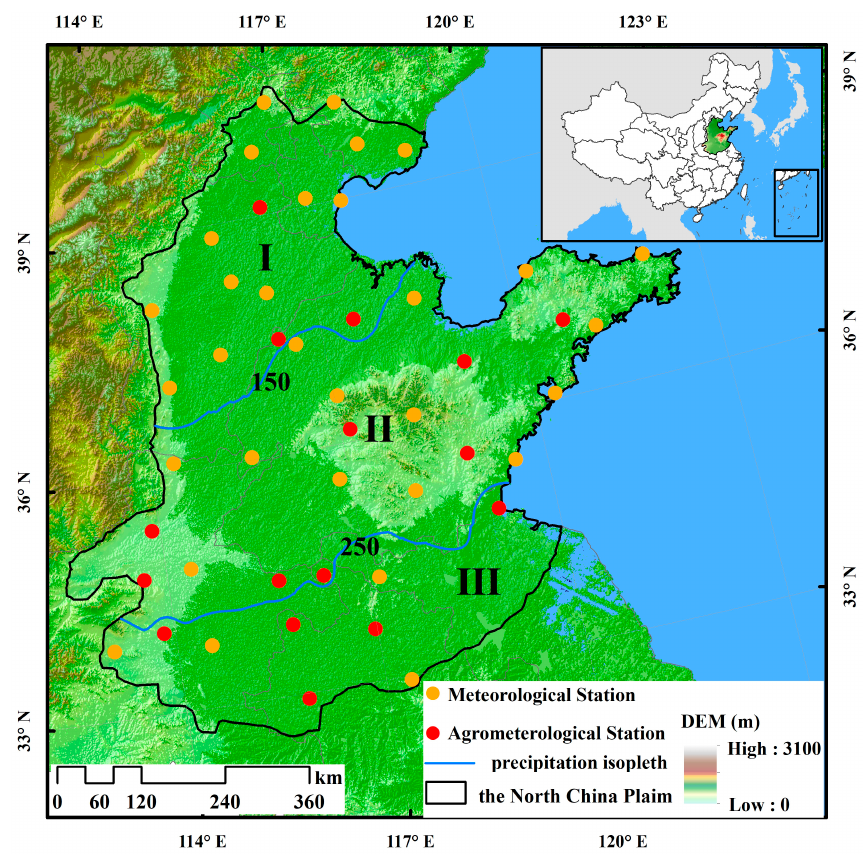
Figure 1. Study area and the distribution of meteorological stations and agrometeorological stations in the NCP.